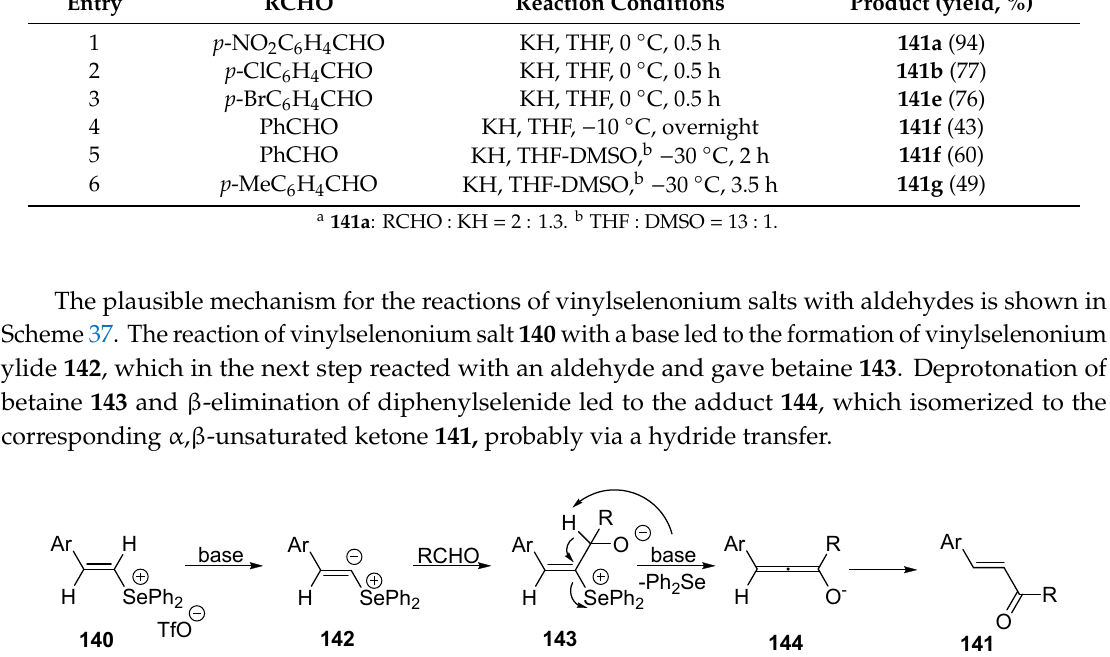
Table 12. Reactions of vinylselenonium salt 140a with aldehydes in the presence of KH. a . Entry RCHO Reaction